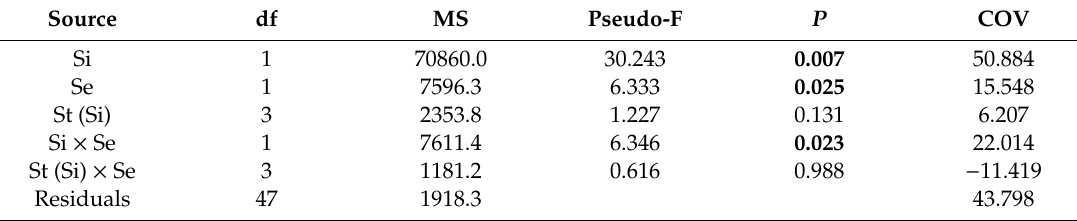
Table 3. Mean squares (MS), pseudo-F ratios, significance levels (P), and components of variation (COV) for permutation multivariate analyses of variance (PERMANOVA) tests using Bray–Curtis similarity matrices from abundance of fish assemblages showing differences in site (Si), station (St, nested within Si), season (Se), and interactions terms in the lower Nakdong River, South Korea; bold letters indicate significance at P < 0.05.